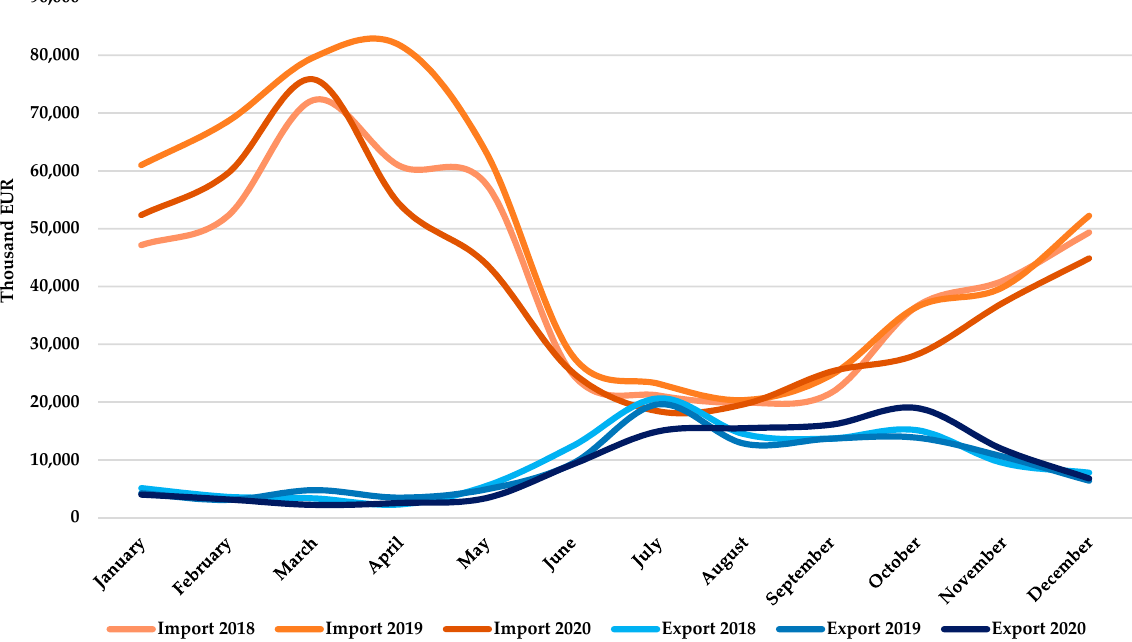
Figure 7. The vegetable Romanian import and export volumes per month. Source: authors’ own design.